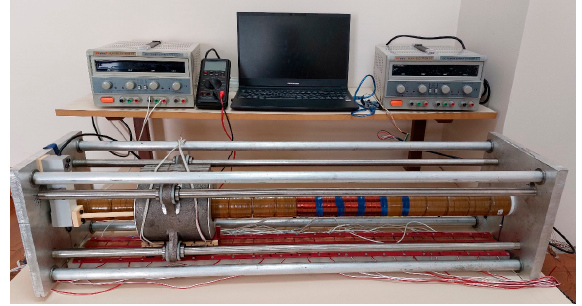
Figure 12. Photo of the manufactured CDCLM.